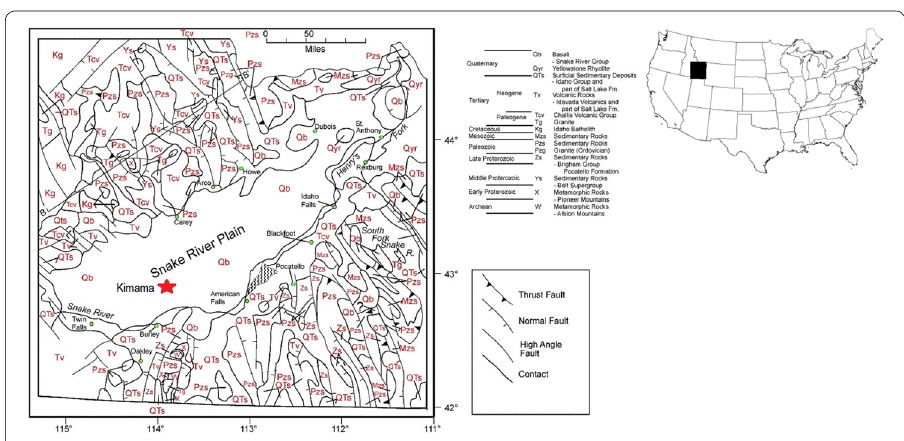
Fig. 1 Project location map. The Kimama drill site is marked with a red star (Adapted from Link et al.